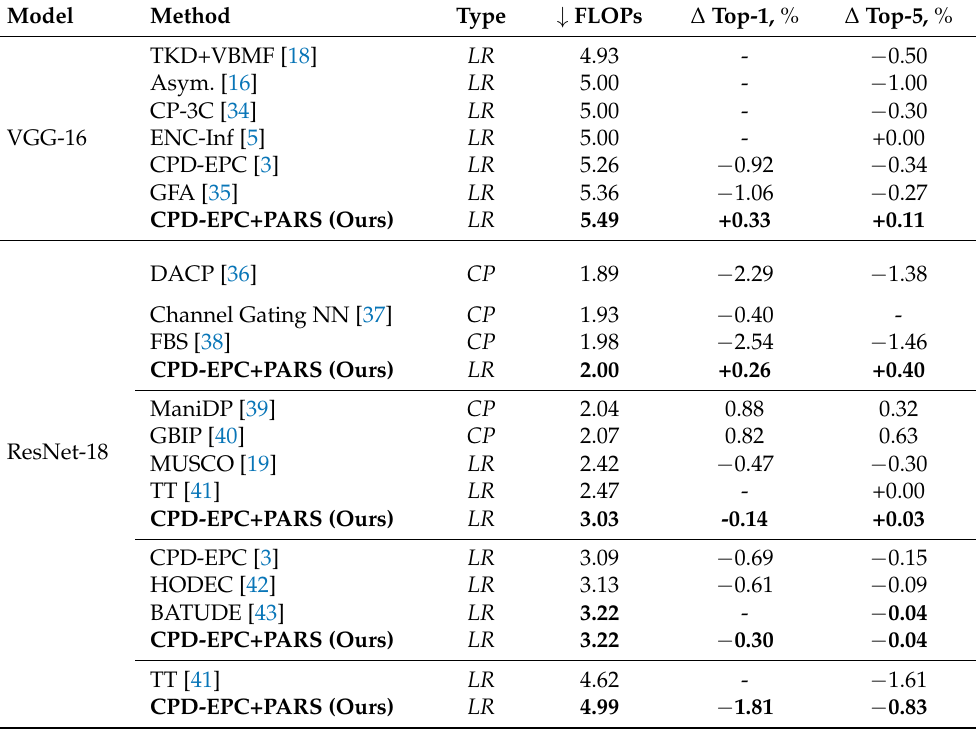
Table 3. Comparison of different model compression methods on the ILSVRC-12 validation dataset. The FLOPs column denotes the compression of the computations; the ∆ top-1 and ∆ top-5 columns ↓ denote the differences in top-1 and top-5 accuracy from the original model—the higher, the better.